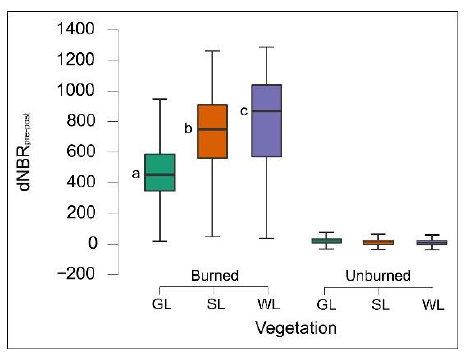
Figure 2. Post-fire burn severity (dNBR pre-post ) in the study area. ( a ) Map of burn severity levels. The histogram in the map shows the percentage distribution of severity levels in the total burned area. The reference system is WGS84 – UTM. ( b ) Percentage distribution of severity levels among grass- lands (GL), shrublands (SL), and woodlands (WL). ( c ) Percentage distribution of severity levels within the vegetation types.